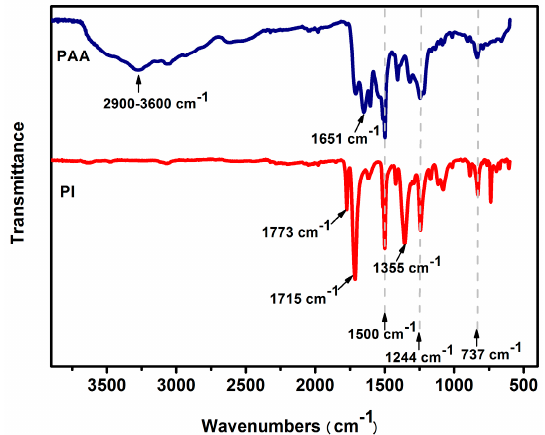
Figure 6. Fourier transform infrared spectroscopy (FTIR) spectrum of nanofibers before and after imidization.